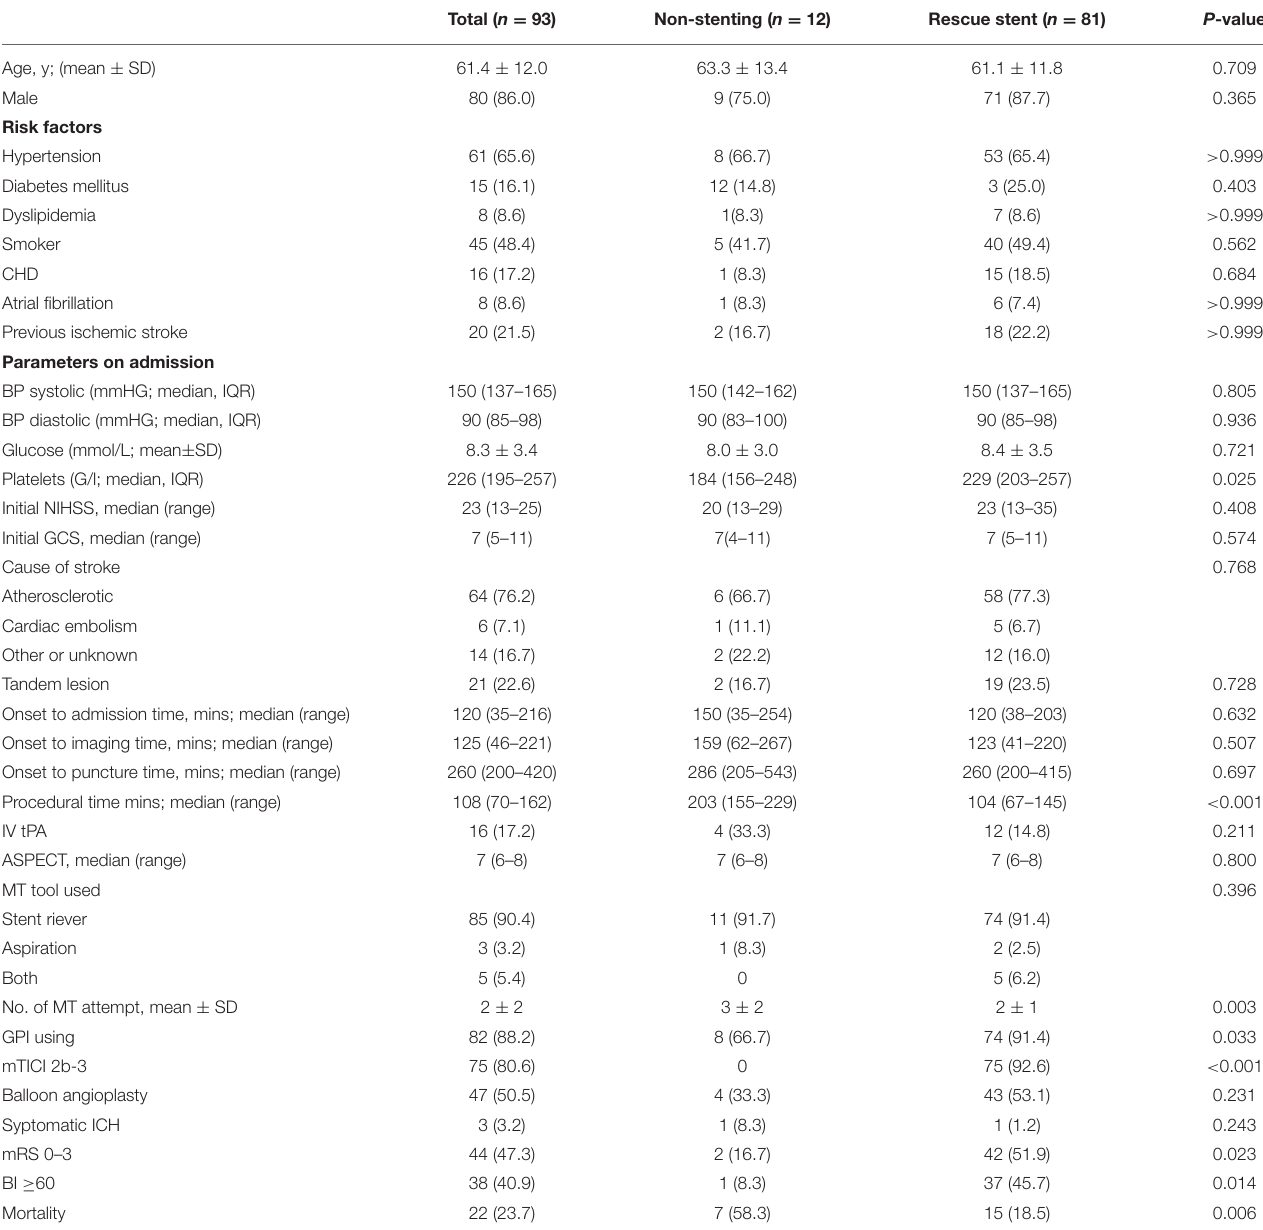
TABLE 1 | Comparisons of the clinical, laboratory test, procedural factors and outcomes of acute posterior circulation stroke due to basilar artery occlusion between the rescue stenting and non-stenting groups.